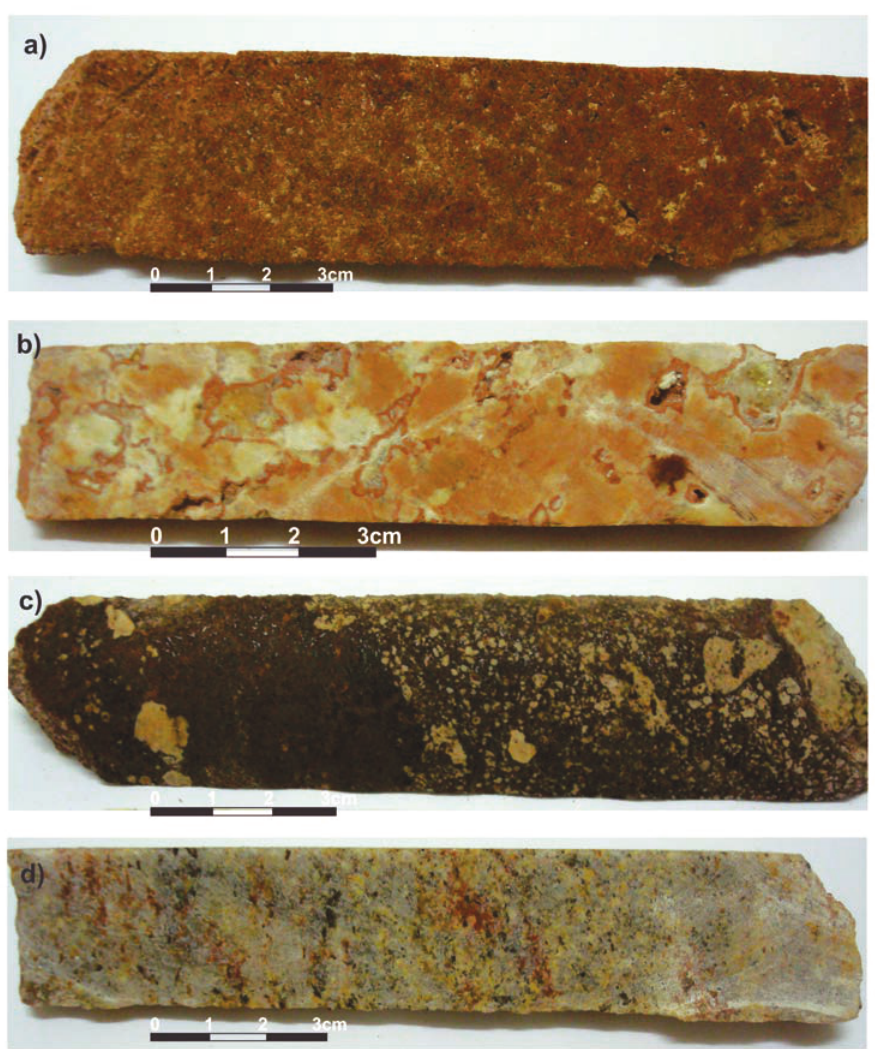
Figure 9 - The main ore types of Itataia U-P deposit: a) collophanite; b) episyenite where vacuoles are filled with collophane and carbonate; c) carbonaceous breccia; d) disseminated